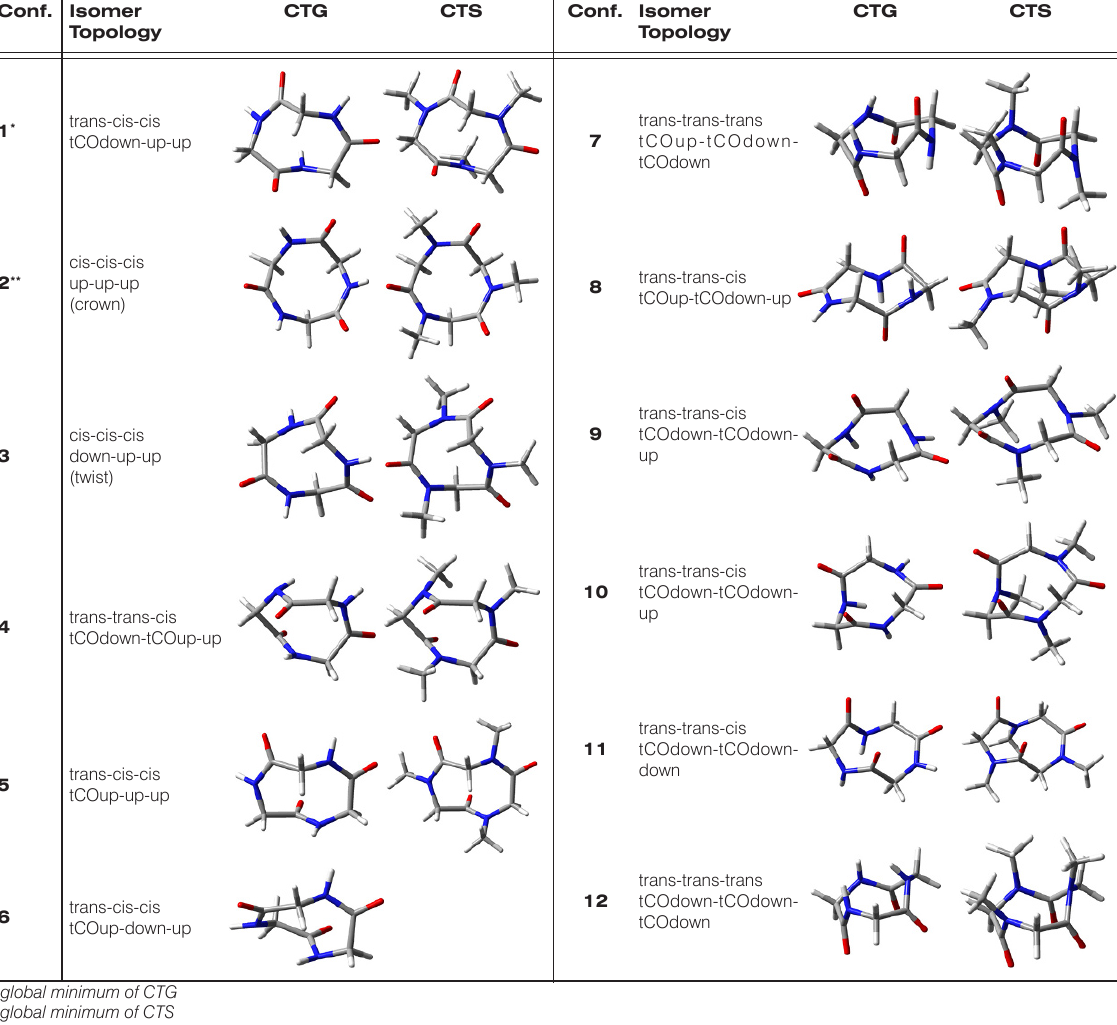
Table 1. The different conformers obtained for CTG and CTS. The corresponding isomer and topology type are also shown. Conf. Isomer